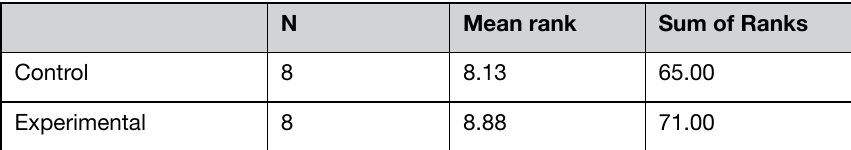
The majority of the participants were Black. The sampling resulted in more female participants in the control group and more males in the experimental group. More participants had a right­ sided Bells Palsy.